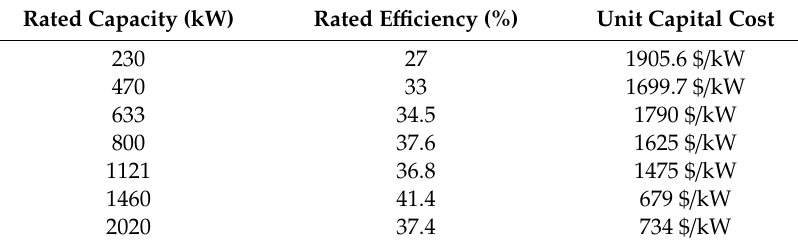
Table 3. Technical features of the power generate unit (PGU).